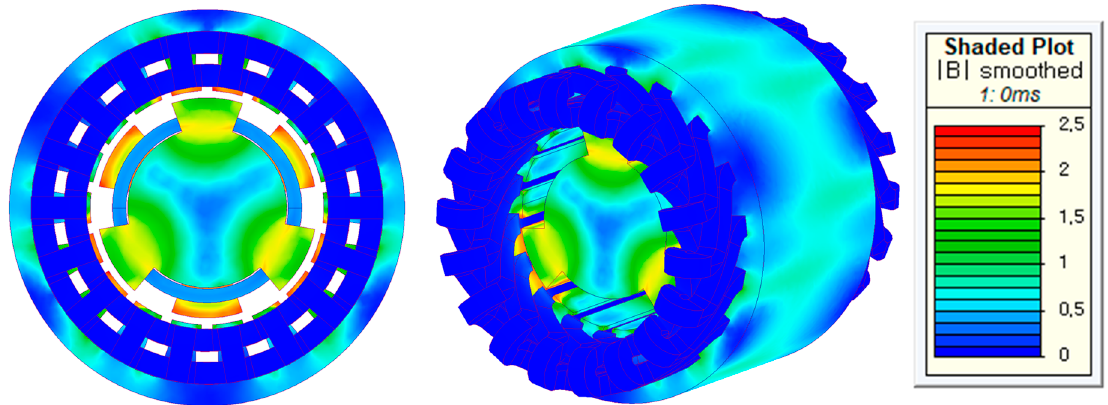
Figure 13. Magnetic field distribution of the HTS homopolar synchronous machine.